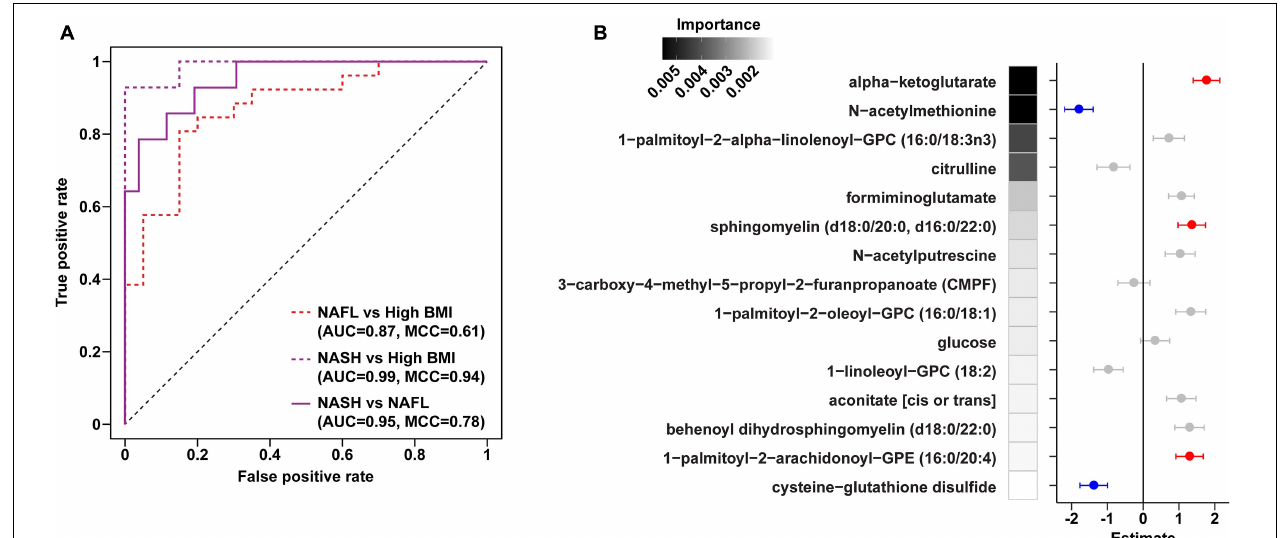
FIGURE 3 | Plasma metabolite binary classification models against “high BMI” or “NAFL” baselines. (A) ROC curves of binary RF models for each comparison as indicated. (B) Forest plot of linear regression coefficients (“Estimate”) for features selected in the binary NAFL vs. NASH plasma metabolite RF model. Positive (red) and negative (blue) coloring denotes metabolites significantly increased and decreased in NASH relative to NAFL, respectively. Error bars show standard errors of the regression coefficients. RF model importance values are shown as shaded